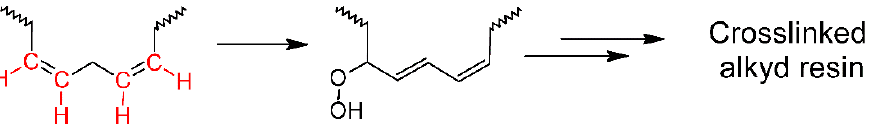
Table 5. Kinetic parameters for formulations of the binder S471 1